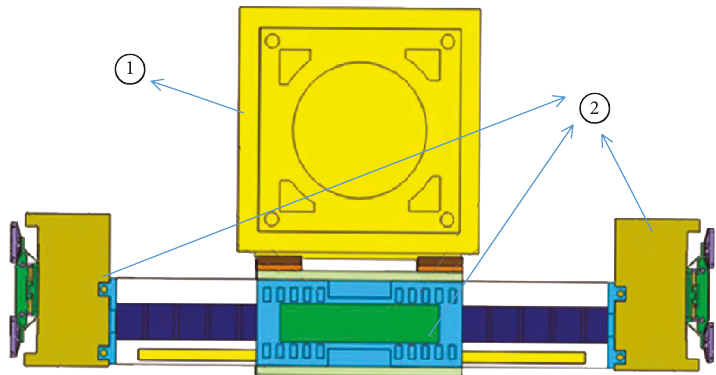
Figure 2: Wafer stage. ① short-stroke module; ② long-stroke module.